Question: Provide a one-line summary of what is displayed.
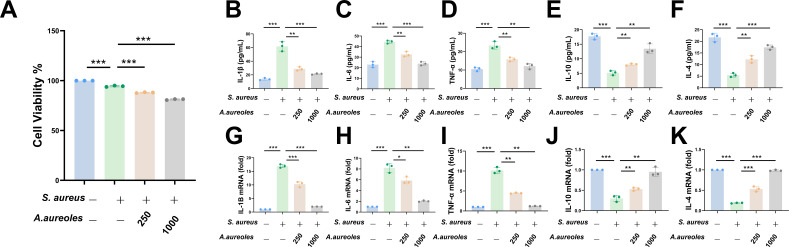
Answer: A. aureoles GGNSJ001 protects RAW 264.7 cells against S. aureus -triggered inflammation. Cell viability was measured by CCK8 staining ( A ). ELISA was used to detect the expression levels of inflammatory factors IL-1β , IL-6 , TNF-α , IL-10, and IL-4 proteins ( B–F ). The relative mRNA levels of IL-1β , IL-6 , TNF-α , IL-10 , and IL-4 were assessed by qRT-PCR ( G–K ). The error bars represent the standard error of the mean. * P < 0.05, ** P < 0.01, and *** P < 0.001. All data are representative of three independent biological experiments performed in triplicates.